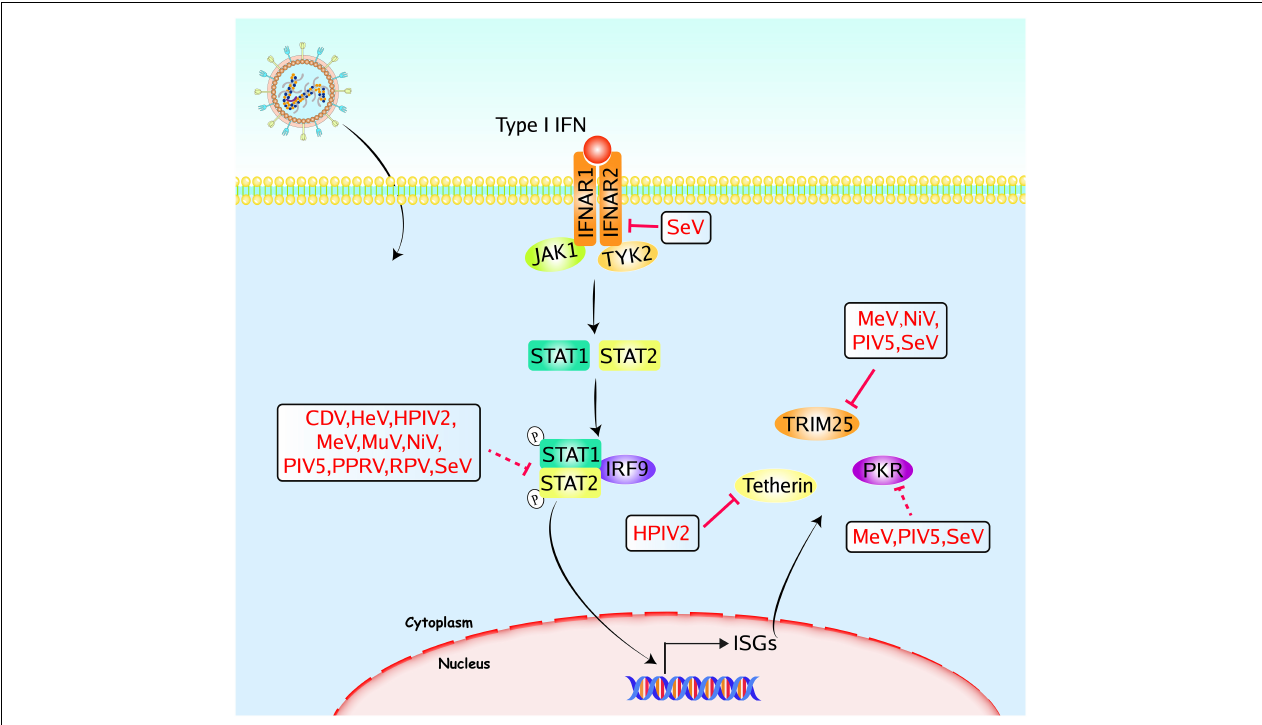
FIGURE 3 | Paramyxoviruses accessory proteins-mediated evasion of the IFNAR-JAK-STAT signaling pathway. Following the binding of cytokines to the specific receptors, STATs are activated by members of the JAK family. Then they dimerize and translocate to the nucleus and regulate the expression of target genes, including ISGs. Accessory proteins from paramyxoviruses interact with adaptors to block the signal transduction, and some accessory proteins directly target ISGs to evade the innate immune responses. The V proteins of CDV, HeV, HPIV2, MeV, MuV, NiV, PIV5, PPRV, RPV, and SeV could inhibit STAT1/STAT2 mediated signaling pathways. The SeV C protein could inhibit IFNAR2, and the V proteins of MeV, NiV, PIV5, and SeV could inhibit TRIM25. The HPIV2 V protein could inhibit tetherin, the C proteins of MeV or SeV, and the MeV V protein could inhibit PKR. The PIV5 P and V proteins could inhibit the activation of PKR. Red solid lines indicate confirmed interactions between adaptors and accessory proteins, and red dashed lines indicate uncertain interactions or unknown underlying mechanisms; P,